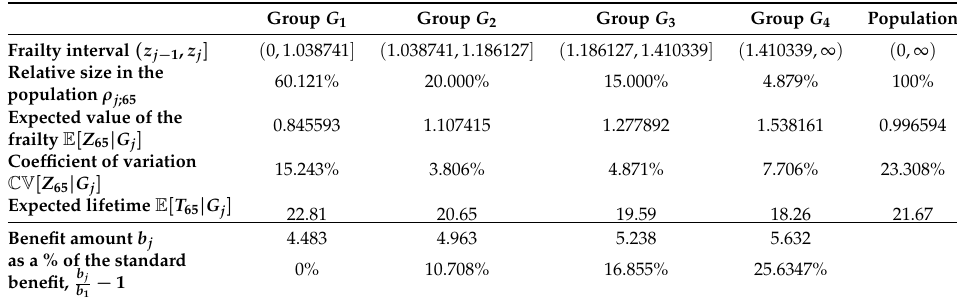
Table 14. Portfolio G: tariff structure and benefit amounts.